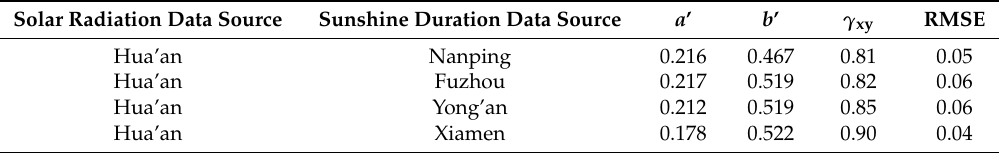
Table 2. Linear regression analysis of clearness index and sunshine duration fraction using sunshine duration for four cities.